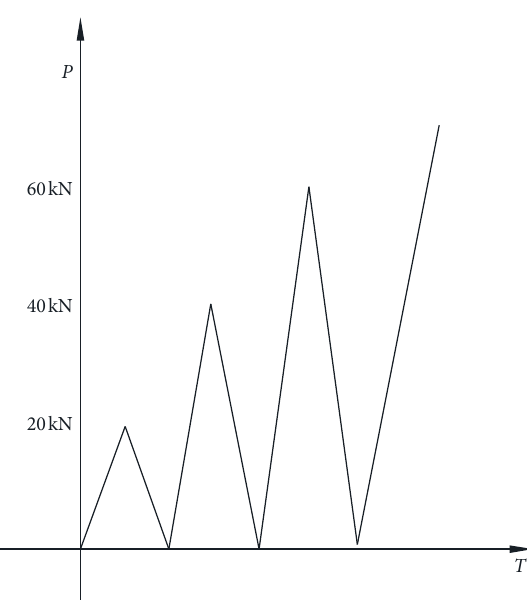
Figure 5: Loading